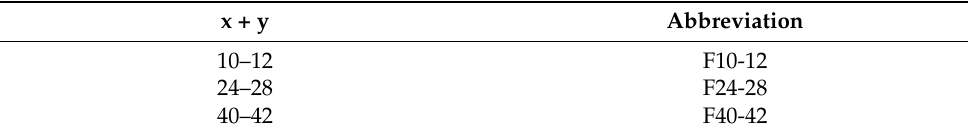
Table 1. Abbreviations for fullerenols C 60,70 O y (OH) x .